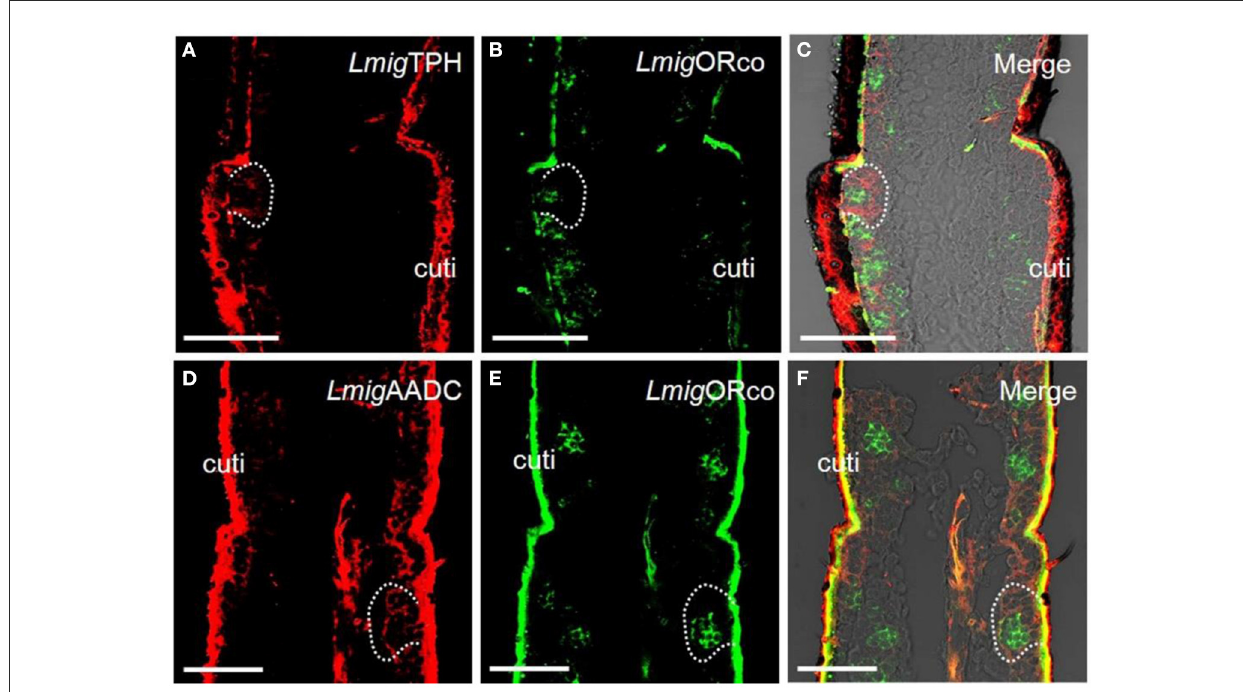
FIGURE1 Localization of 5-HT using antiserum against 5-HT and localization of two key enzymes for 5-HT biosynthesis by dual-color fluorescence in situ hybridization in locust antennae. (A) The enzyme Lmig TPH was stained by an antisense probe against Lmig TPH RNA with digoxigenin (DIG), red. (B) Odorant receptor co-expressed protein ( Lmig ORco) was stained by an antisense probe against Lmig ORco RNA with biotin (BIO), green. (C) A and B merged with the brightfield image. (D) The enzyme Lmig AADC was stained by an antisense probe against Lmig AADC RNA with DIG, red. (E) Lmig ORco was stained by an antisense probe against Lmig ORco RNA with BIO, green. (F) D and E merged with the brightfield image. Ba, basiconic sensilla; Tr, trichoid sensilla; Co, coeloconic sensilla; cuti, cuticle; tra, trachea. Scale bar: 100 µ